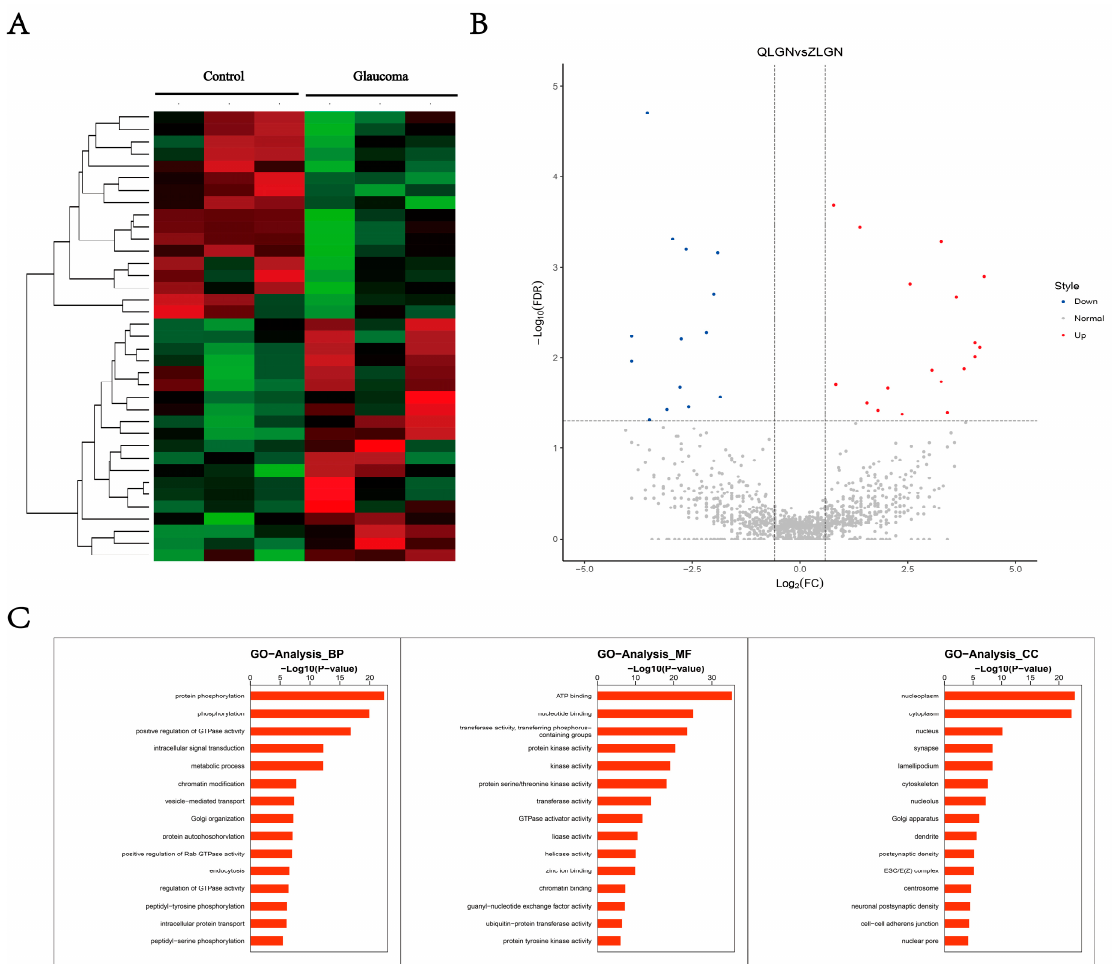
Figure 2. Differentially expressed circRNAs in LGN of macaque glaucoma model. ( A ) Heat map of differentially expressed circRNAs; ( B ) volcano map of differentially expressed circRNAs; ( C ) GO pathway analysis for differentially expressed circRNA host